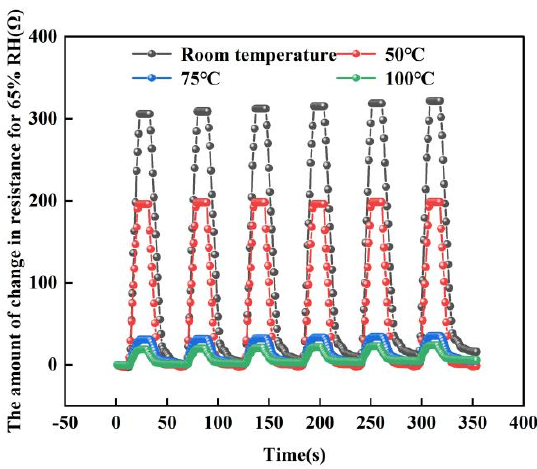
Figure 16. The repeatability test at different temperatures (At 65%RH).